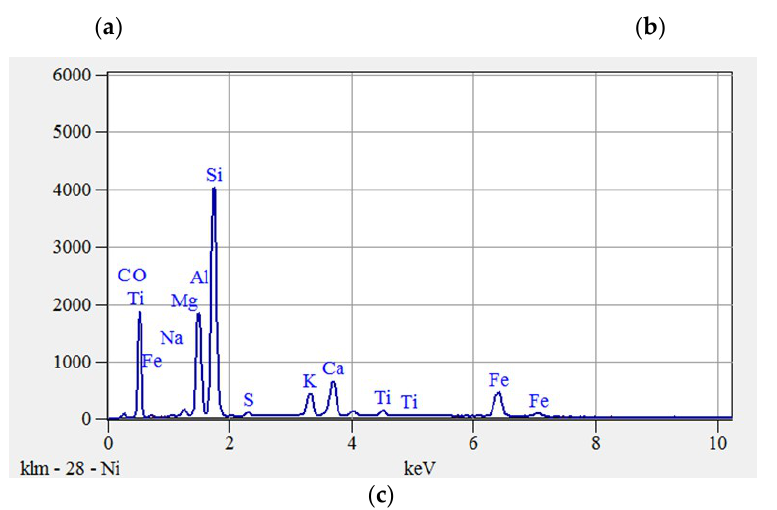
Figure 1. SEM micrographs of site soil at ( a ) 500 × magnification, ( b ) 1000 × magnification, and ( c ) EDX spectra of expansive soil (from several determinations).